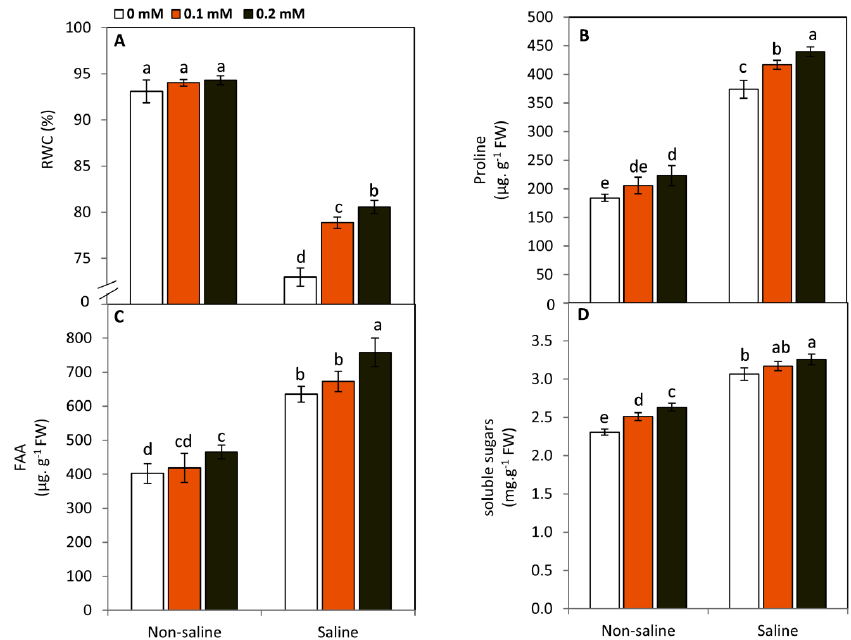
Figure 5. Effect of exogenous folic acid (FA; 0, 0.1, and 0.2 mM) on leaf relative water content; RWC ( A ), proline ( B ), free amino acids, FAA ( C ), and soluble sugars ( D ) of snap bean plants grown under non-stressed and saline-stressed (50 mM, NaCl) conditions. Values are the averages of three replicates ± SD. Different letters indicate significant differences according to Duncan’s multiple range tests ( p < 0.05).